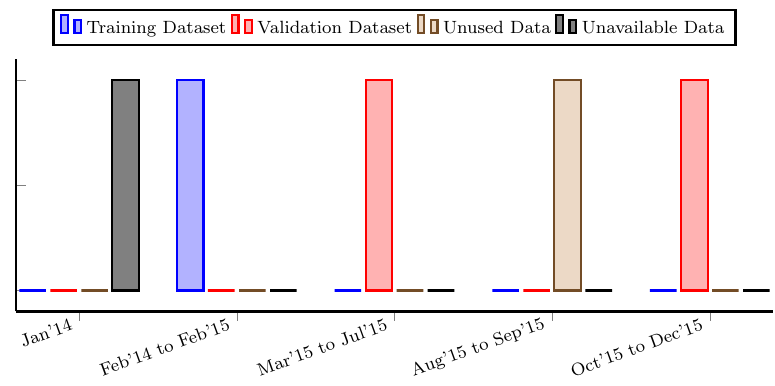
Figure 7. Distribution of